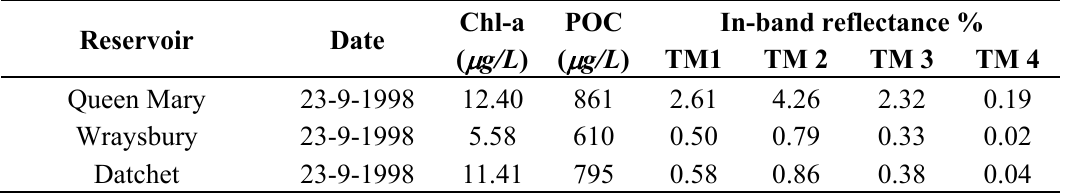
Table 1. Simulated in-band reflectance values and water quality data for samples obtained during the spectro-radiometric surveys. chl-a: chlorophyll-a; POC: particulate organic